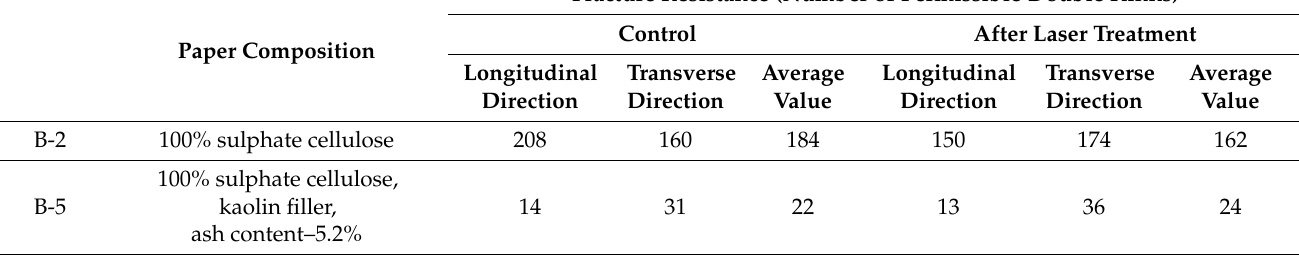
Table 2. The effect of laser processing on the physical and mechanical properties of paper (index- fracture resistance). Paper Composition Fracture Resistance (Number of Permissible Double Kinks) Control